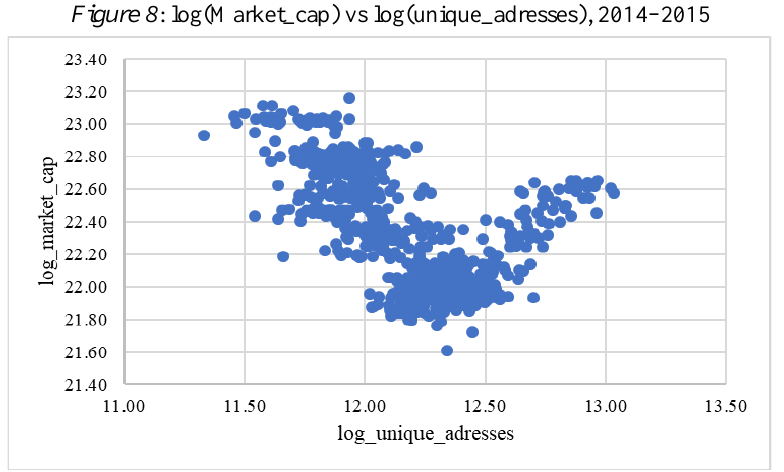
Figure 8 : log(Market_cap) vs log(unique_adresses),